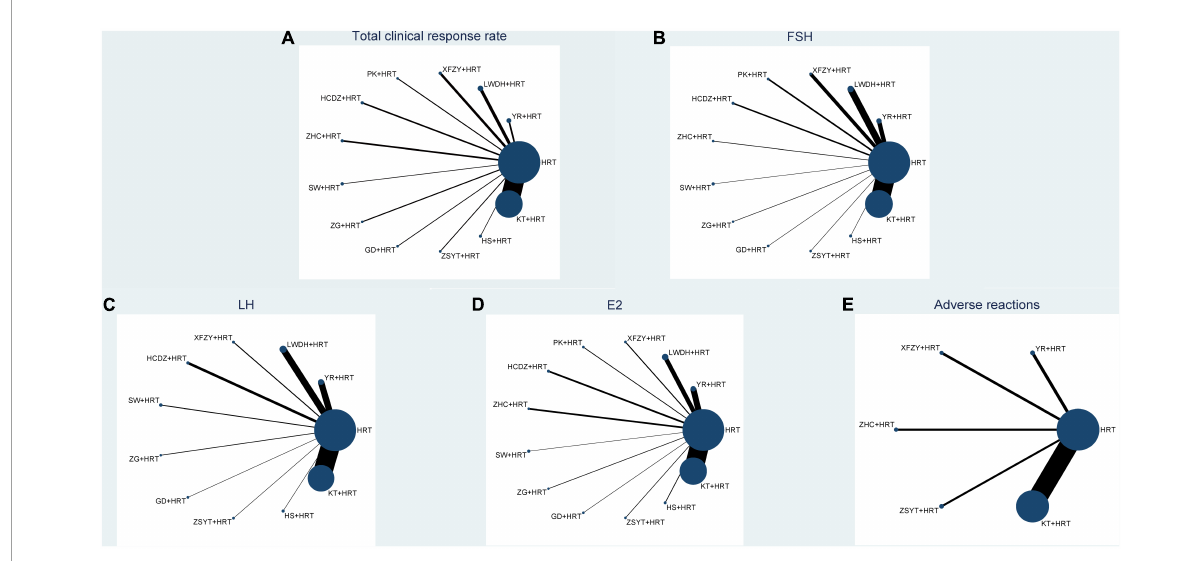
FIGURE2 Network plot of all the trials based on the outcomes. P.S: (A) total clinical response rate; (B) FSH; (C) LH; (D) E2; (E) adverse reactions; HRT, hormone replacement therapy; YR, Fuke Yangrong Capsule; LWDH, Liuwei Dihuang Pills; XFZY, Xuefu Zhuyu Capsule; PK, Peikun pills; HCDZ, Heche Dazao pills; ZHC, Ziheche Capsule; SW, Siwu Mixture; ZG, Zuogui pills; GS, Guishen pills; ZSYT, Zishen Yutai pills; HS, Huanshao Capsule; KT, Kuntai